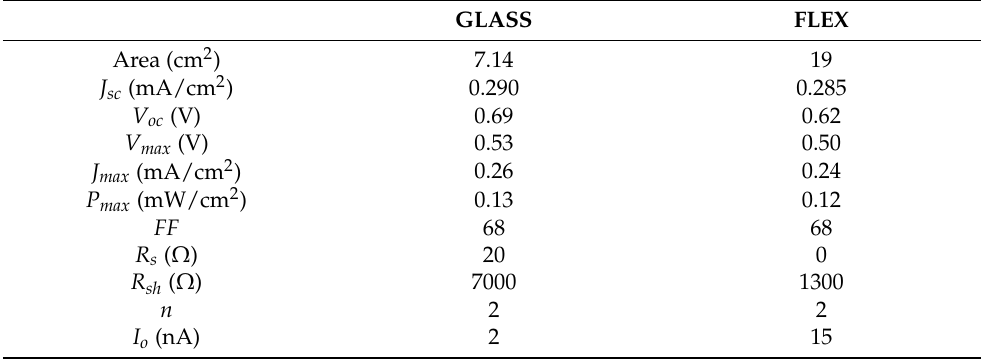
Table 1. Main photovoltaic parameters obtained from DSSC